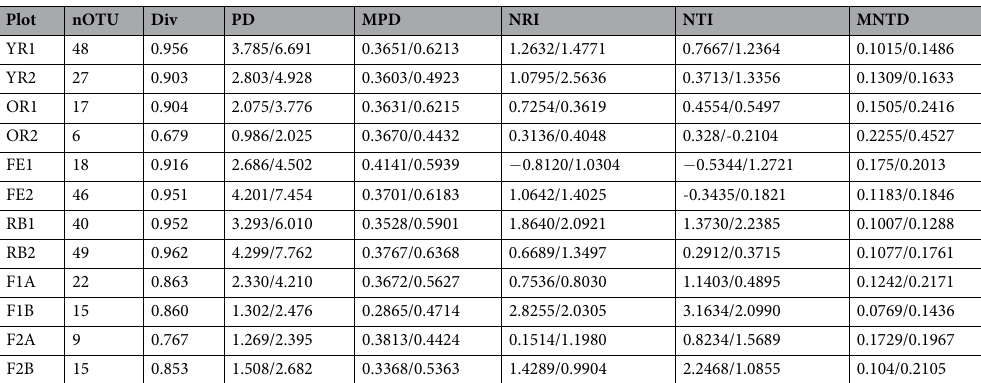
Table 3. Community diversity (various measures of) as compared between sites of differing habitat type. For each site the values are calculated over all replicates. Abbreviations: nOTU = Number of OTU, equivalent to species richness; Div = Simpsons Diversity Index, calculated from number of individuals of each OTU, and gives probability that two randomly selected individuals will be of the same species; PD = Phylogenetic diversity 76 ; MPD = mean phylogenetic distance between a randomly selected pairs; NRI = Net relatedness index (an overall measure); NTI = Nearest taxon index (a measure restricted to the terminals of the tree); MNTD = mean nearest taxon distance, average phylogenetic distance to nearest neighbor (excluding conspecifics), this index has also been referred to as mean nearest neighbor distance. NRI and NTI are standardized forms of MPD and MNTD, respectively, and are significant where > 1.96 (clustered) or <− 1.96 (dispersed). Two values are given for phylogeny-derived indices, those calculated from tree including new OTU only/calculated from tree including both new OTU and reference